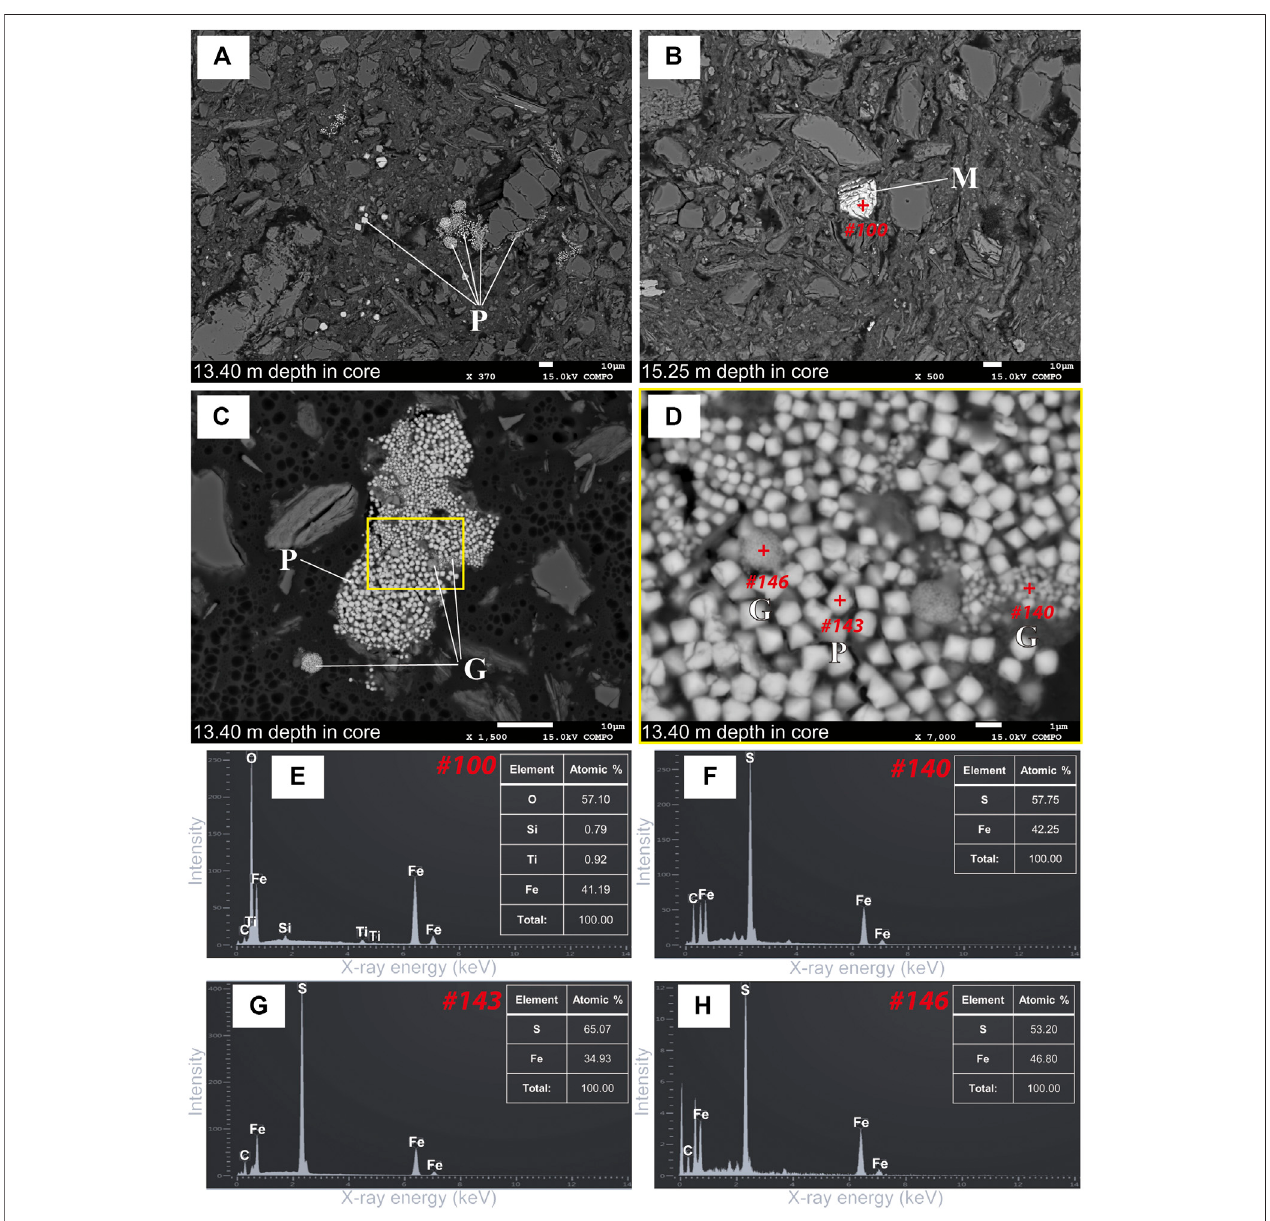
FIGURE7| BSE imagesand X-rayEDSspectraofmagnetic mineralspresentedinbulksedimentsfrom theYAR-4core. (A) Euhedralpyritegrains,and framboidal and irregular pyrite aggregates (labeled P) in silicate/clay-dominated matrix from the 13.40 m depth sediment sample. (B) Titanomagnetite grain (labeled M) in silicate/ clay-dominated matrix from the 15.25 m depth sediment sample, being probably of detrital origin. Red cross symbol indicates the target point where EDS analysis was conducted. (C) Polyframboidal aggregates of both pyrite (labeled P) and greigite (labeled G) grains from the 13.40 m depth sediment sample. (D) Zoom-in view of (C) .Ultra- fi ne-grainedgregiteaggregates( fi nerthanthesurroundingpyritegrains)withintheaggregatesofpyritecrystalsofvariablesizes.Thegreigitegrainsareroughly bimodal in size. Red cross symbols are the same as in (B). (E – H) EDS spectra of (Ti-poor) titanomagnetite (Fe 3-x Ti x O 4 ; x (cid:1) ∼ 0.1) shown in (B) and pyrite and greigites shown in (D) , respectively, with element compositions in atomic %. Ideal atomic % is given approximately Fe (cid:1) 33, and S (cid:1) 67 for pyrite (FeS 2 ), and approximately Fe (cid:1) 43, S (cid:1) 57 for greigite (Fe 3 S 4 ). The carbon (C) signal of EDS originates from the carbon coating of the sample thin section in preparation for the SEM observation.